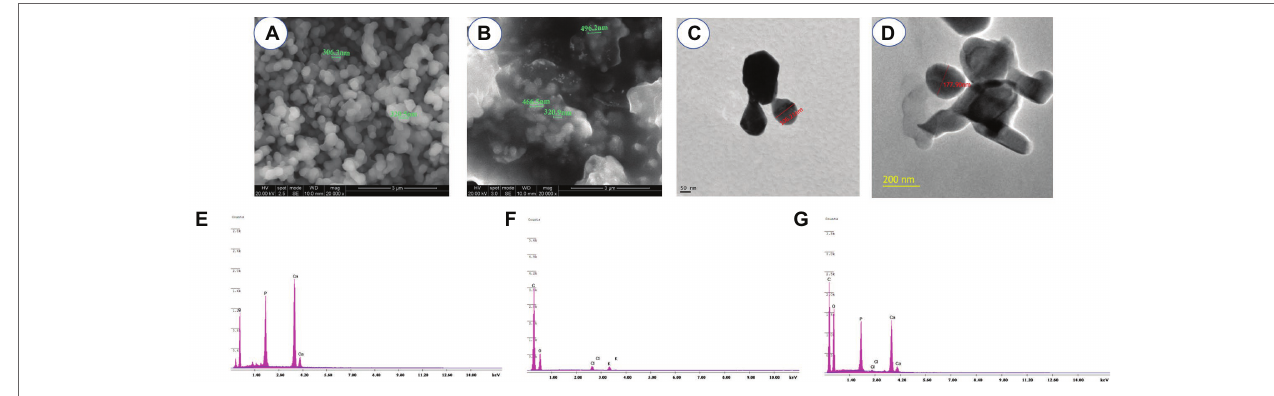
FIGURE 4 | SEM images of (A) hydroxyapatite (HA) and (B) hydroxyapatite– A. indica (HA-AI) composite. HR-TEM image of (C) HA and (D) HA-AI composite. SEM-EDX pattern of (E) HA, (F) AI, and (G) HA-AI